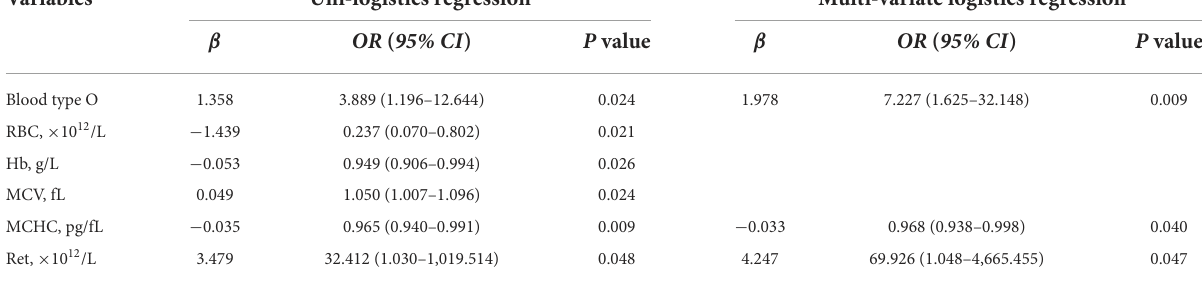
TABLE 2 Univariate and multivariate logistic regression analyses. Variables Uni-logistics regression